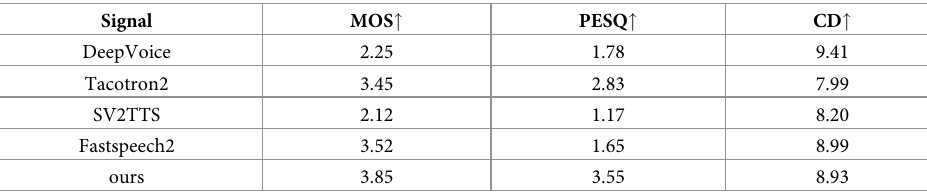
Table 3. MOS standard comparison table. Signal MOS " PESQ "